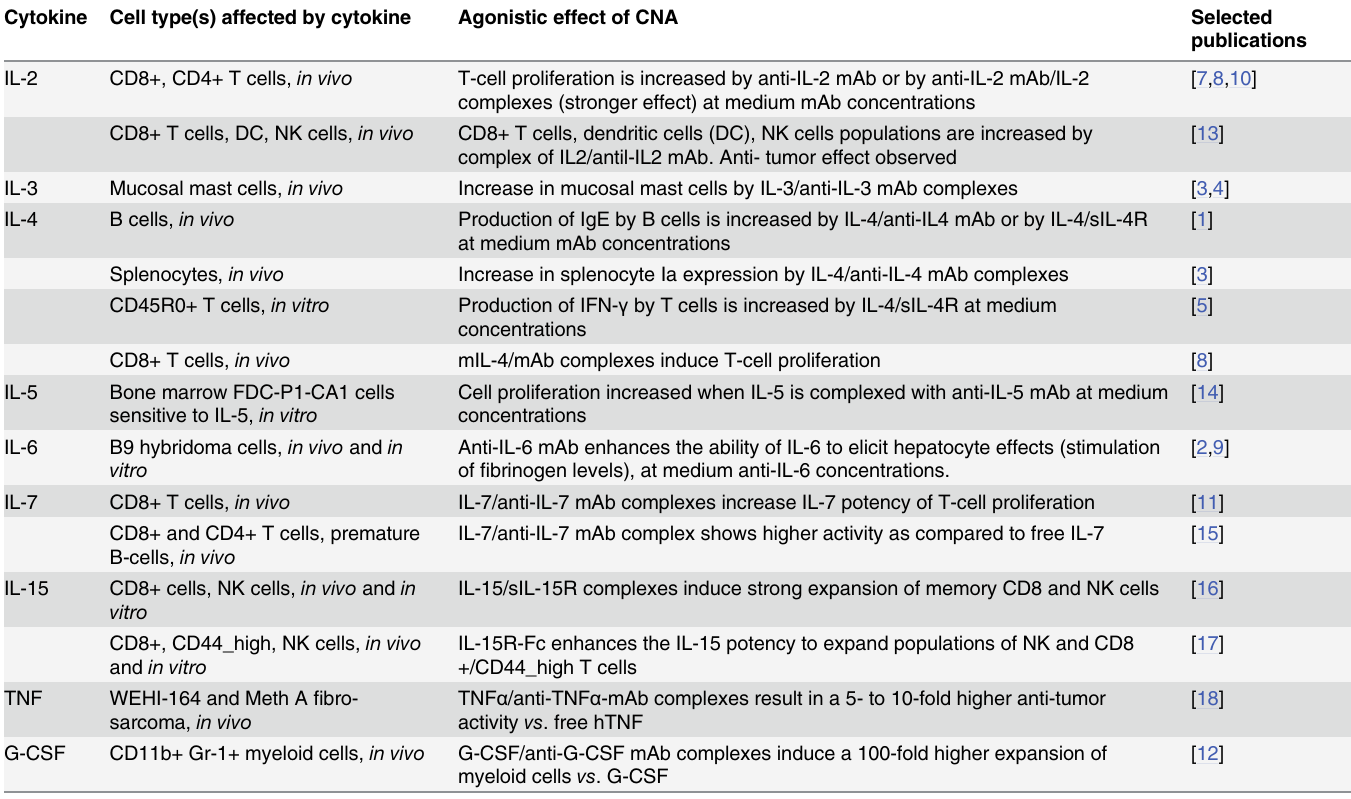
Table 1. Experimentally observed enhancement of cytokine signaling by cytokine-neutralizing antibodies (CNAs). Cytokine Cell type(s) affected by cytokine Agonistic effect of